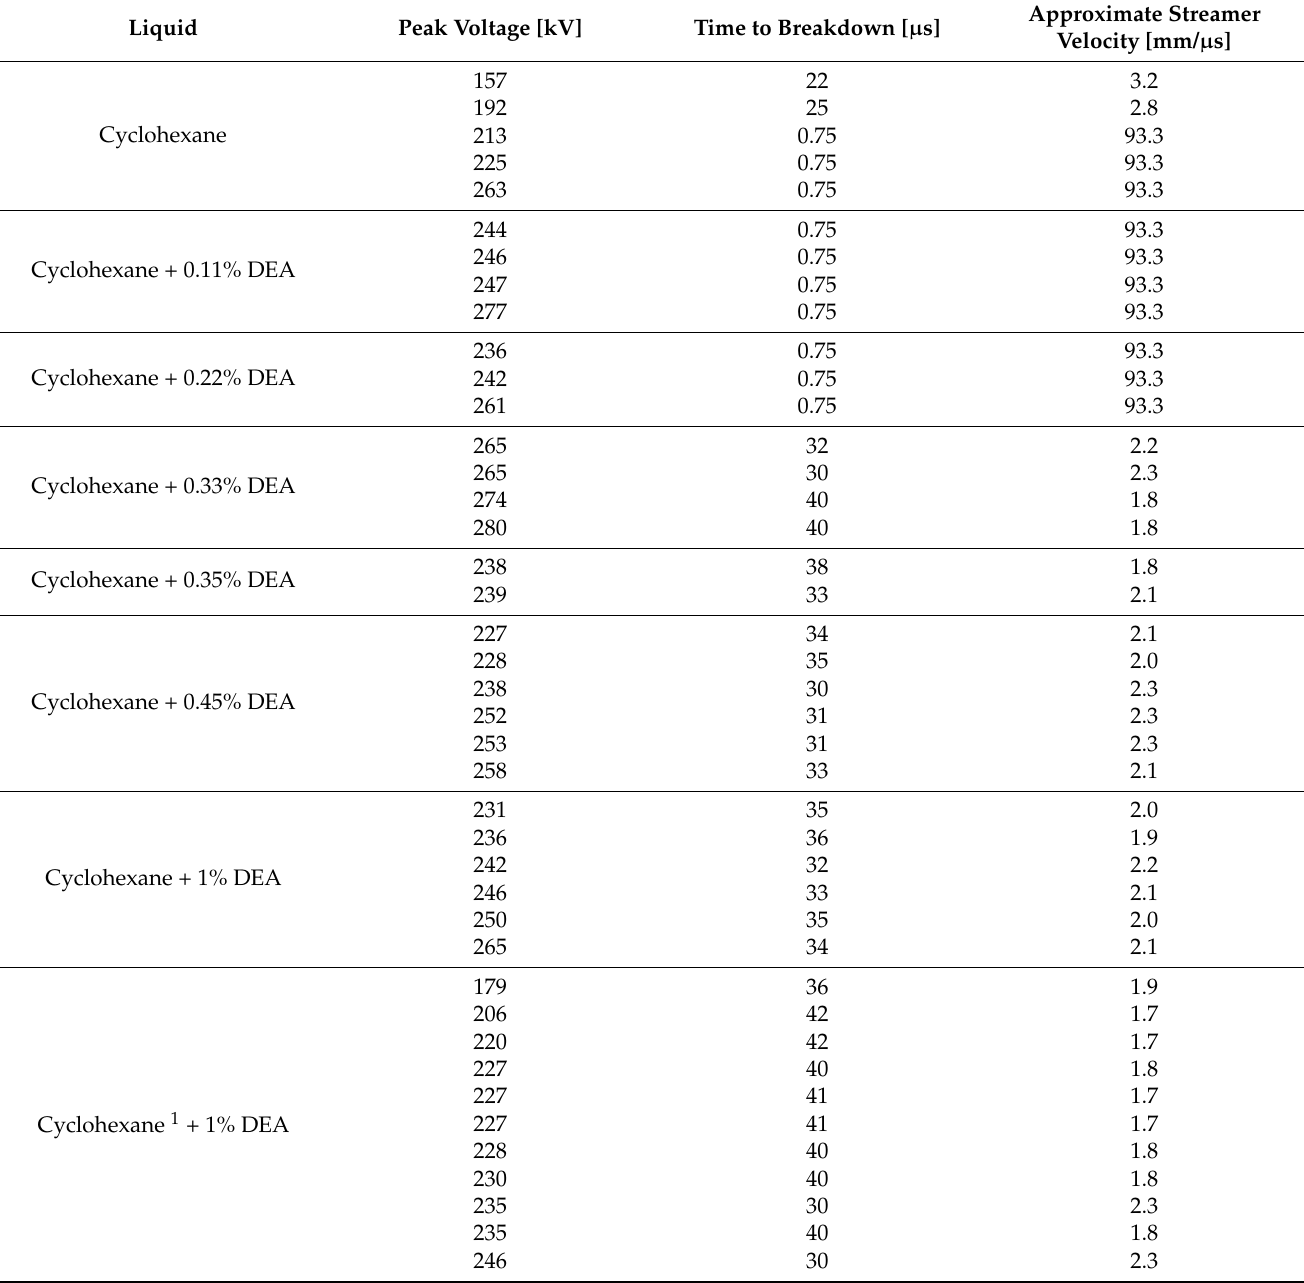
Table 3. The time to breakdown and inferred overall streamer velocity for cyclohexane and different concentrations of DEA in cyclohexane. Applied voltage was a positive polarity lightning impulse (1.2/50 µ s) with a 70 mm gap (point-plane